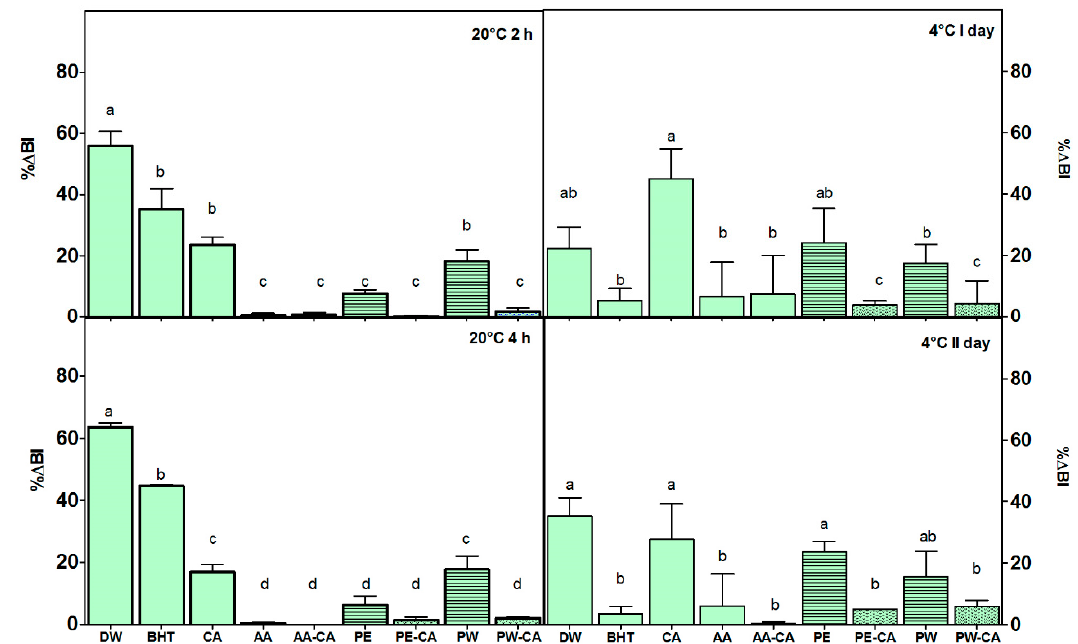
Figure 2. Visual appearance of browning in fresh-cut apples treated with different preservative media (sample codes are described in Table 1). Samples were stored at 20 ± 1 °C (2 and 4 h) and 4 ± 1 °C (1 and 3 days).